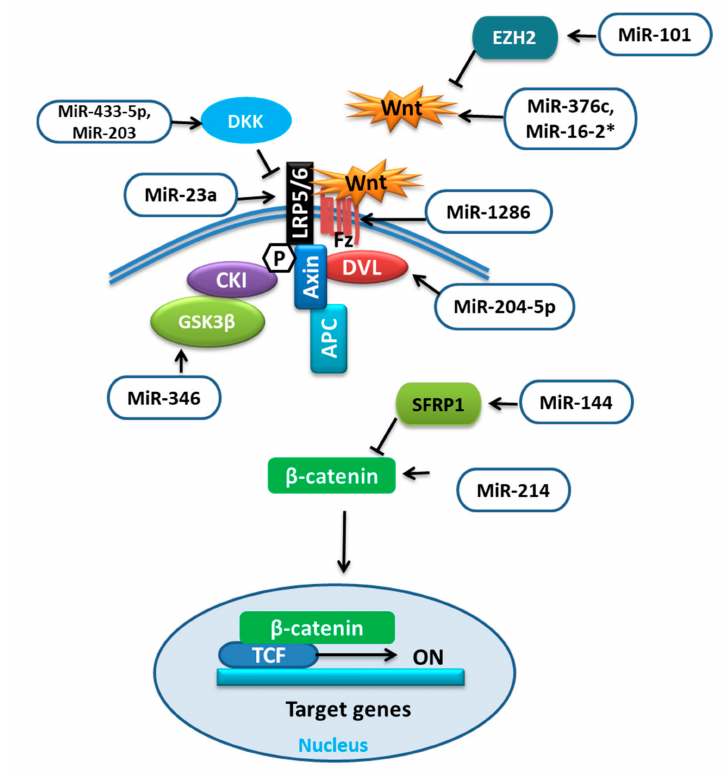
Figure 2. miRNAs targeting di ff erent components of Wnt